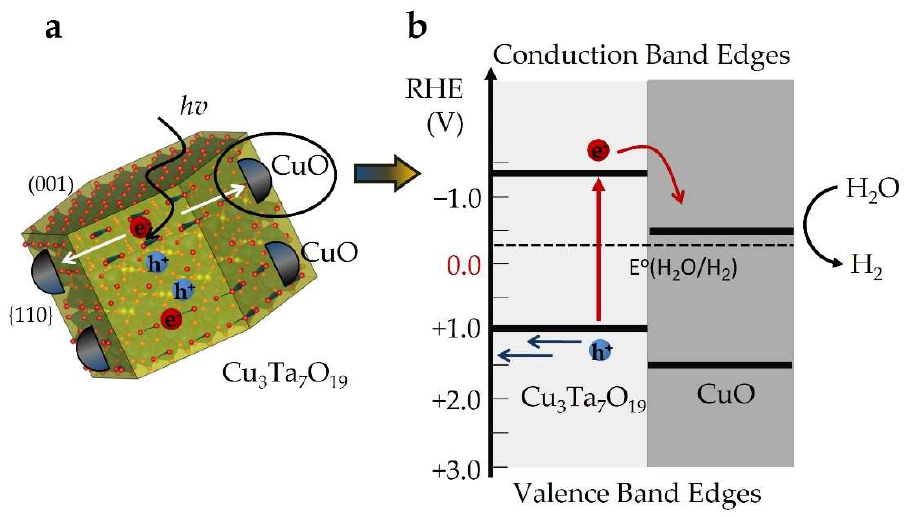
Figure 6. ( a ) Polyhedral model of a Cu 3 Ta 7 O 19 crystallite with CuO surface islands on its {110} faces, and ( b ) alignment of their conduction and valence-band edge energies at the interface, with a band-offset favorable for H 2 O reduction at the surfaces at pH ~ 6.3.